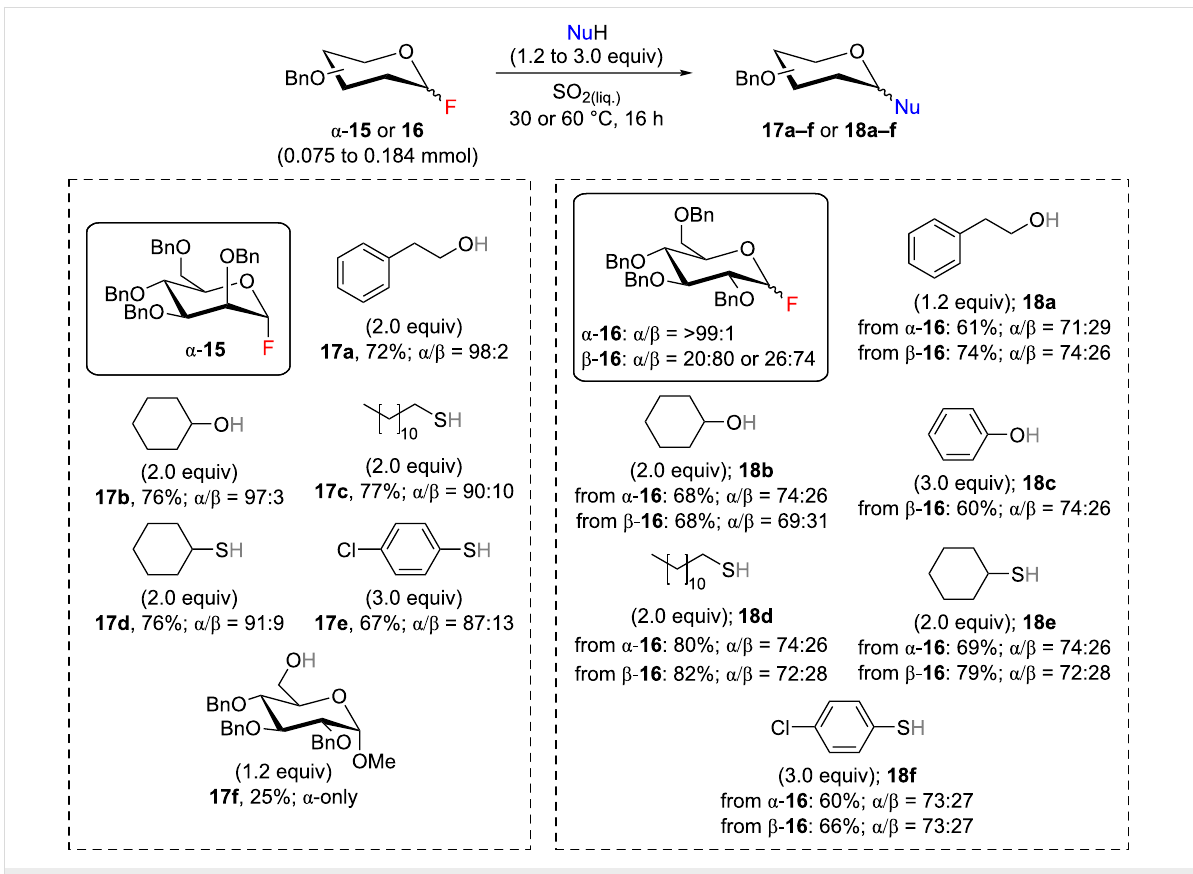
The armed benzyl-protected glycosyl fluorides α - 15 and 16 were more reactive than their acylated analogues and the corre- sponding glycosides 17 and 18 were obtained at lower tempera-